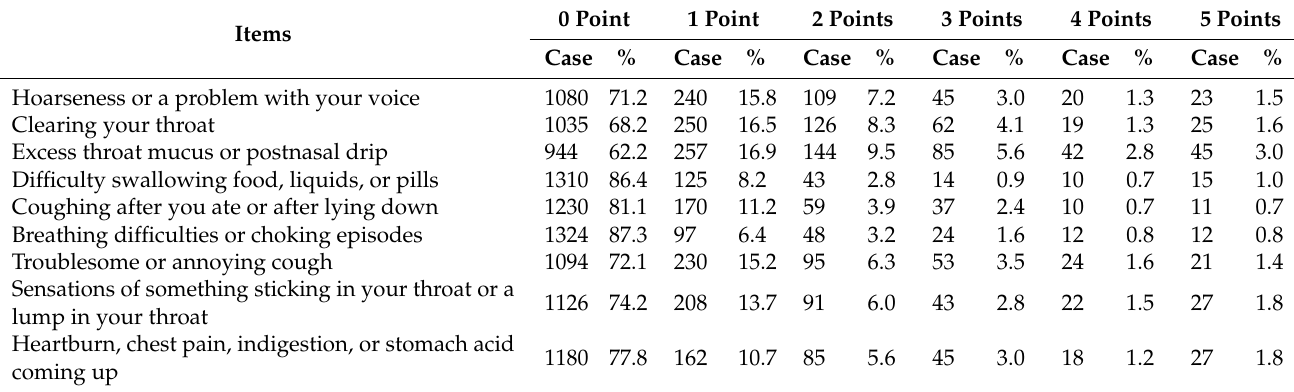
Table A4. The scores of each Reflux Symptom Index items.